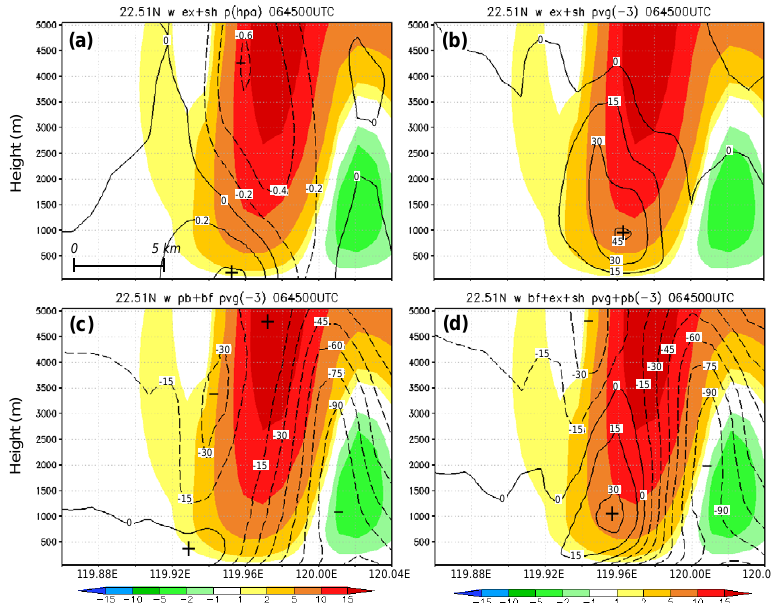
Figure 17. (a) As in Fig. 15c, except for w (ms − 1 , color) and p (cid:48) (about 18km in length) at 06:45UTC, 8 August 2009. (b – d) As in Fig. 16, except for w and the z component of perturbation pressure gradient force (10 − 3 ms − 2 , contours, every 15 × 10 − 3 ms − 2 ) from (b) p (cid:48) along the same cross-section as (a)